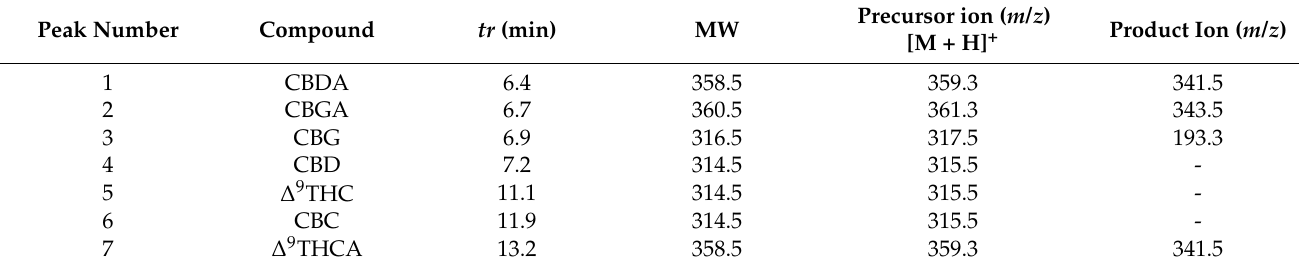
Table 4. Retention times with nano-LC–MS, MS data of the major cannabinoids detected in hemp extracts. Peak Number